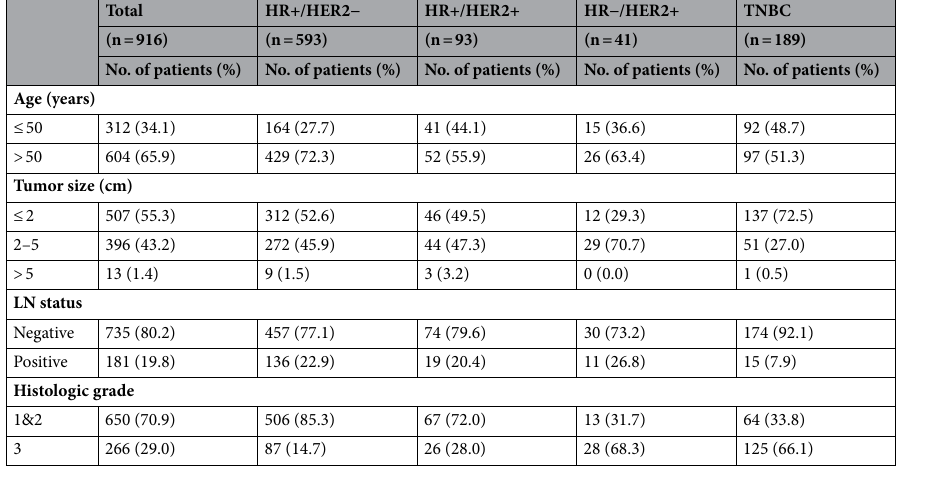
Table 1. Clinical characteristics of the patients included in the discovery dataset. HER2, human epidermal growth factor receptor 2; HR, hormone receptor; LN, lymph node; TNBC, triple-negative breast